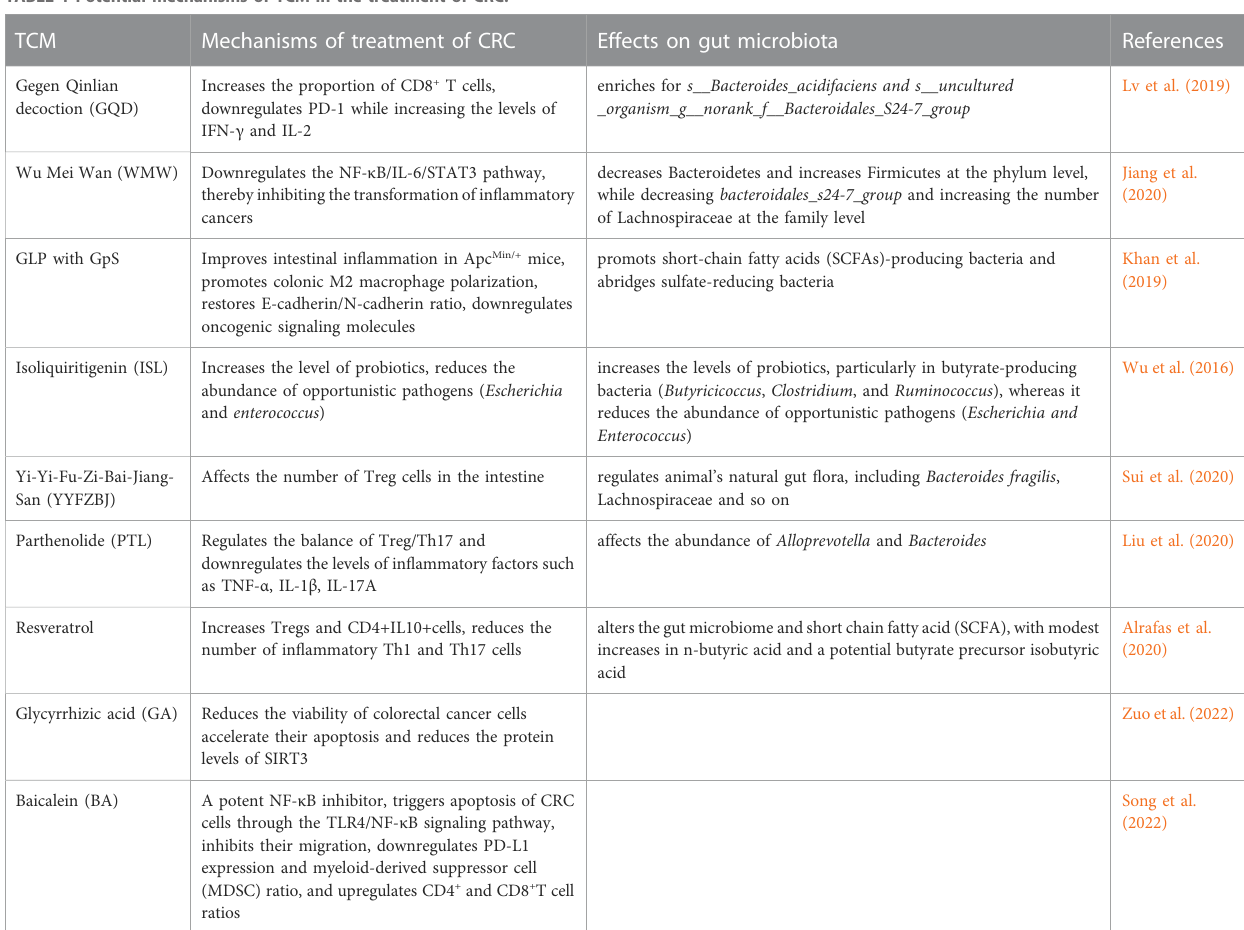
TABLE 1 Potential mechanisms of TCM in the treatment of